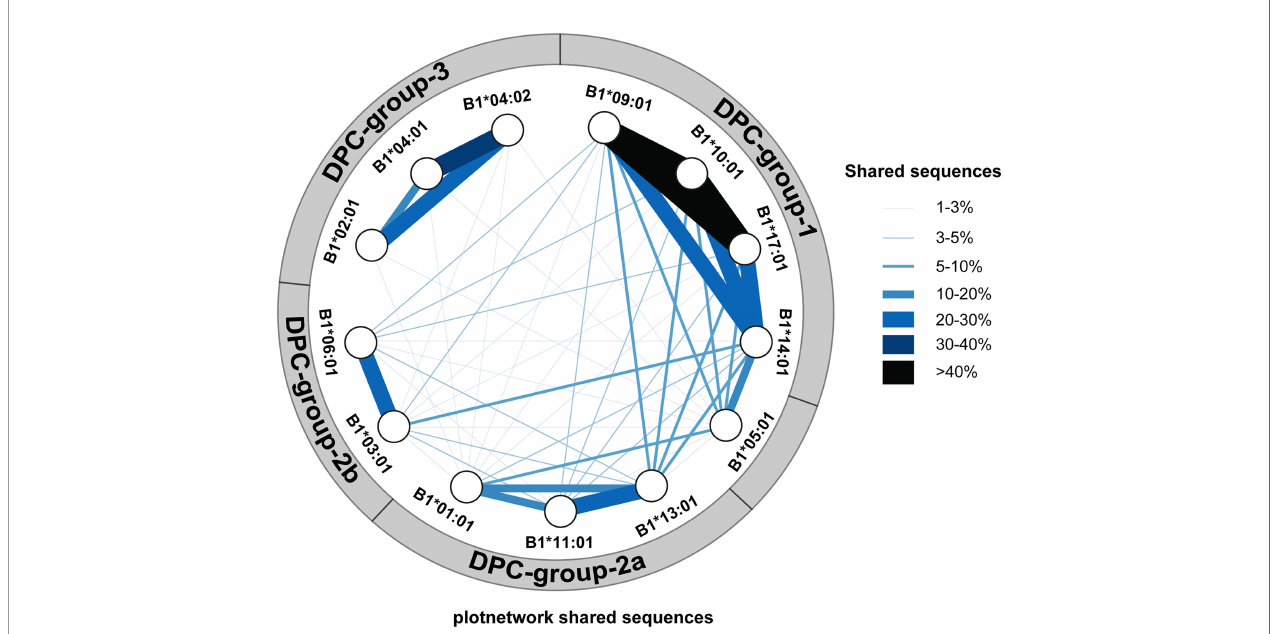
FIGURE 2 | Network of HLA-DP molecules. A network of HLA-DP molecules was generated based on the overlap in presented peptides. The percentage of overlap in presented peptides between the different HLA-DP molecules are illustrated by the thickness and color of the lines as indicated by the legend. The network shows the distinction of four major groups; group DPC-1 consisting of HLA-DPB1*09:01, HLA-DPB1*10:01, HLA-DPB1*17:01 and HLA-DPB1*14:01, group DPC-2A consisting of HLA-DPB1*13:01, HLA-DPB1*11:01 and HLA-DPB1*01:01, group DPC-2B consisting of HLA-DPB1*03:01 and HLA-DPB1*06:01, and fi nally group DPC-3 consisting of HLA-DPB1*02:01, HLA-DPB1*04:01 and cell clones with their single CDR3- b sequence (3 from response 1